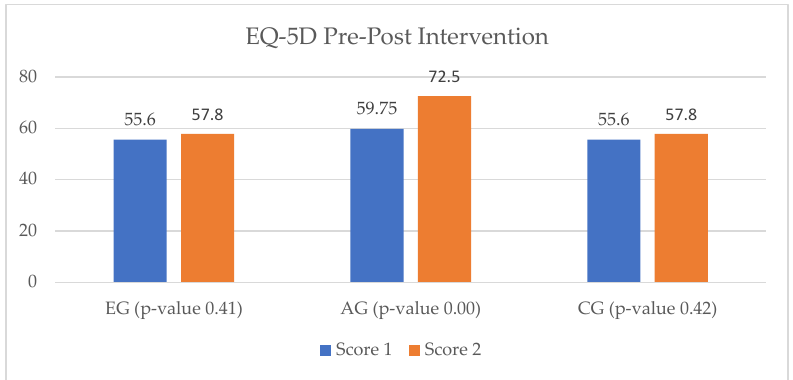
Figure 12. EQ-VAS results for the heart failure study group.